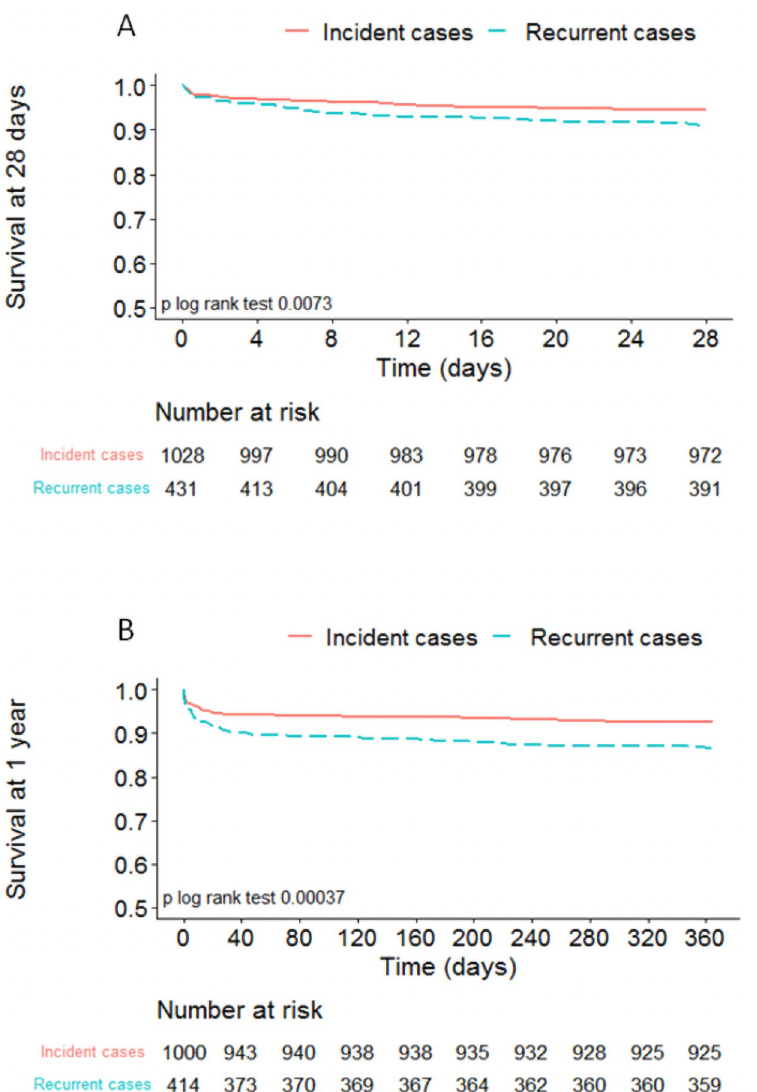
Fig 3. 28-day and 1-year survival curves. A. 28-day survival curves. B. 1-year survival curves.